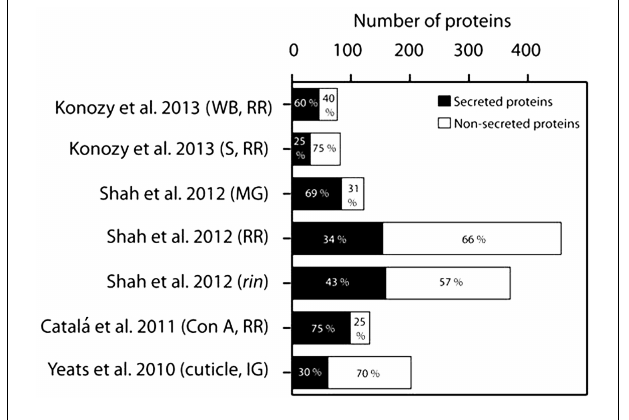
FIGURE 1 |Analysis of the proportions of proteins identified as entering the secretory pathway, as reported in the cited publications, from immature green (IG), mature green (MG), and red ripe (RR) stage wild type fruit and those of the rin mutant, using SignalP 4.1 Server (www.cbs.dtu.dk/services/SignalP). S, soluble;WB,